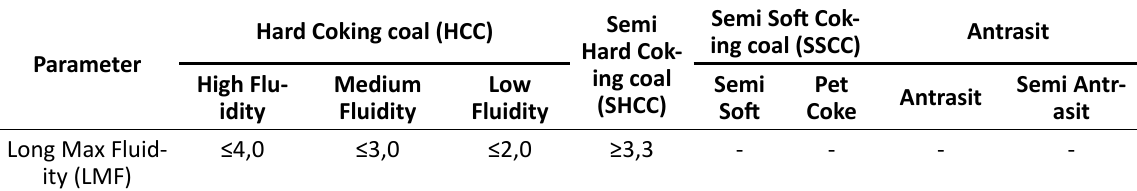
Table 1: Coking coal Classification (Posco